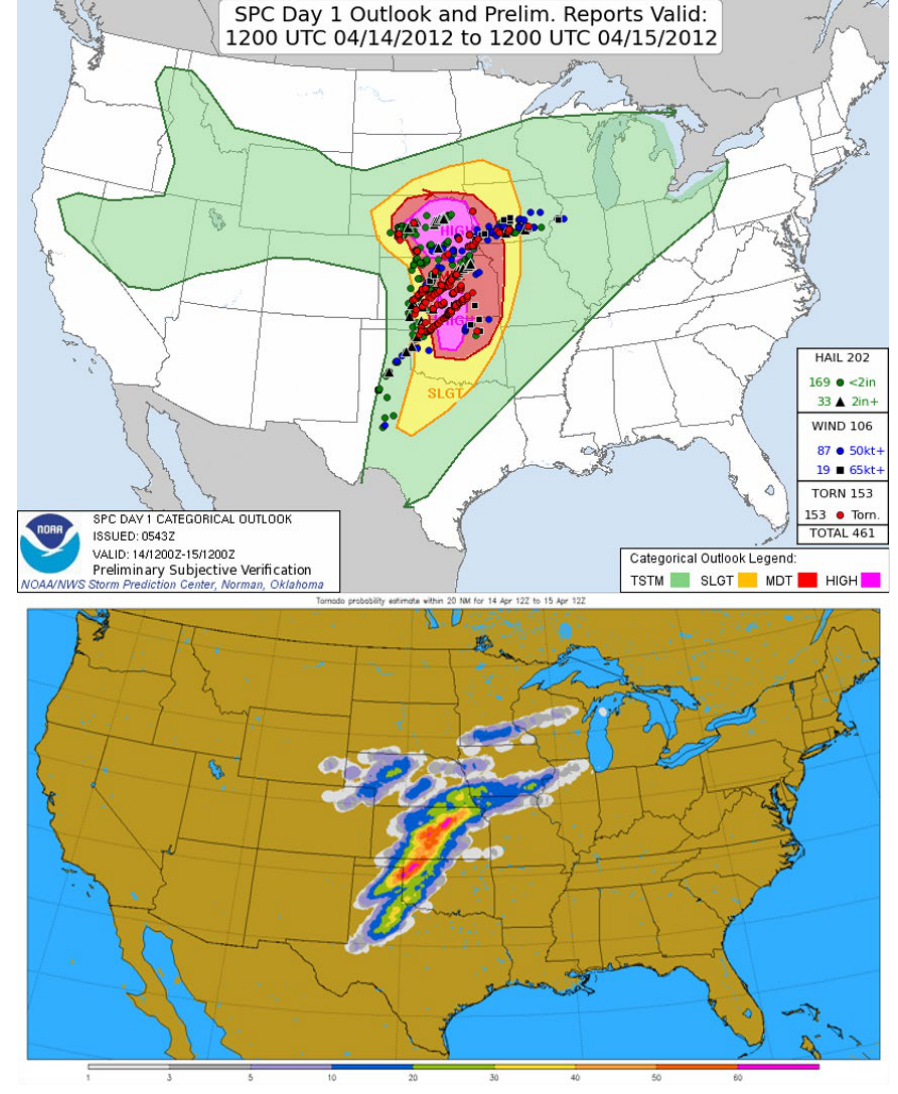
Figure 8. ( Top ): NOAA Storm Prediction Center outlook for 1200 UTC 14 Apr 2012 to 1200 UTC 15 Apr 2012 issued at 0543 UTC on 14 Apr 2012 along with US National Weather Service preliminary observed tornadoes (red dots) from 1200 UTC 14 Apr 2012 to 1200 UTC 15 Apr 2012. Slight risk corresponds to a 2% chance of a tornado within 25 nautical miles during the valid period, moderate a 15% chance, and high a 30% chance. ( Bottom ): 36 to 60 hour forecast of tornado probabilities (percent) within 20 nautical miles from the 0000 UTC 13 Apr 2012 run of 4-km MEPS (valid 1200 UTC 14 Apr to 1200 UTC 15 Apr). 24-hour probabilities calculated using the hourly probabilities, assuming complete independence from hour to hour.